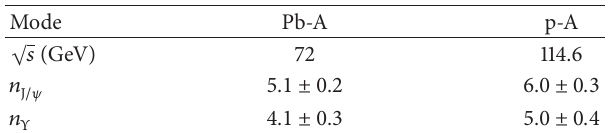
Table 2: Values of 𝑛 used at √𝑠 = 72 GeV and √𝑠 = 114 . 6 GeV for J /𝜓 and Υ